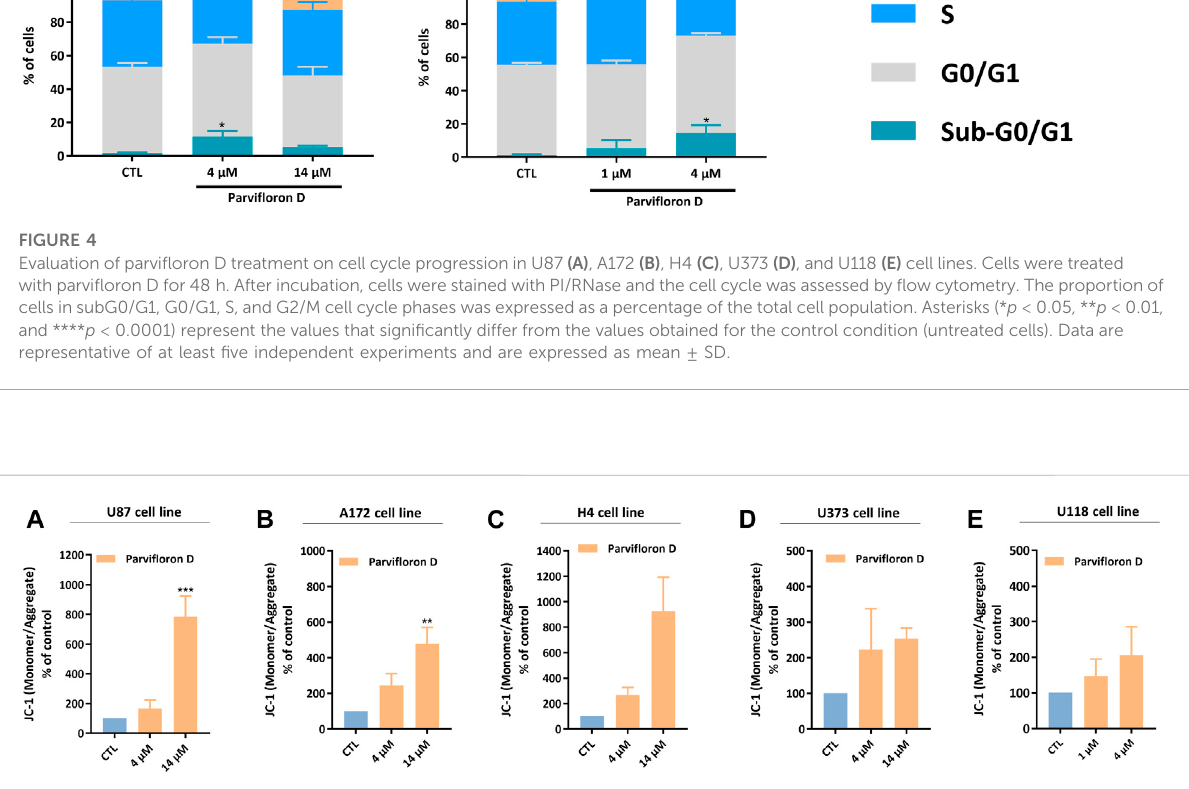
FIGURE 5 AnalysisofthemitochondrialmembranepotentialinU87 (A) ,A172 (B) ,H4 (C) ,U373 (D) ,andU118 (E) celllinesaftertreatmentwithparvi fl oronD for 48 h. The monomeric or aggregate form of JC-1 probe depends on the mitochondrial membrane potential. An increase in the monomer/ aggregate (M/A) ratio indicates a decrease in the mitochondrial membrane potential. Results are expressed as M/A ratio of JC-1, which was calculated asthefractionofMFIobservedfor eachmolecule.Asterisks(** p < 0.01 and *** p < 0.001)representthevalues that signi fi cantly differ from the control (untreated cells). Data were presented as mean ± SD and are representative of at least three independent